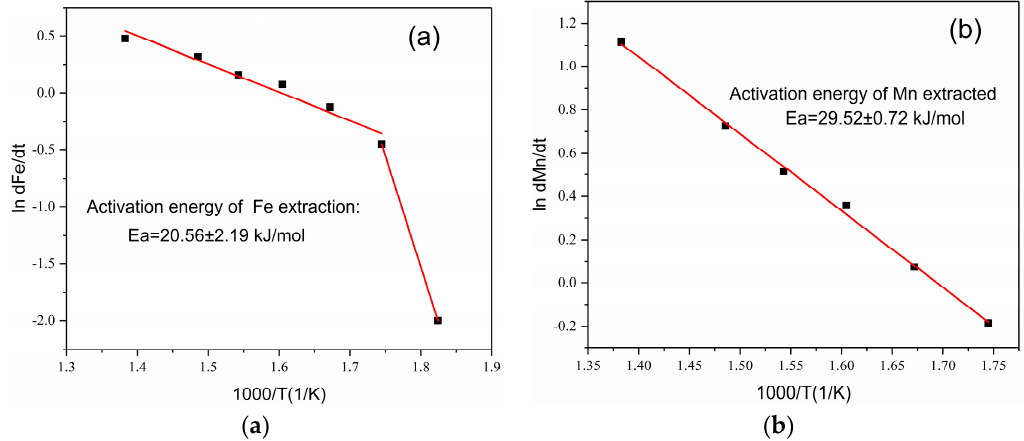
Figure 4. The determination of apparent activation energy of ( a ) iron and ( b ) manganese.